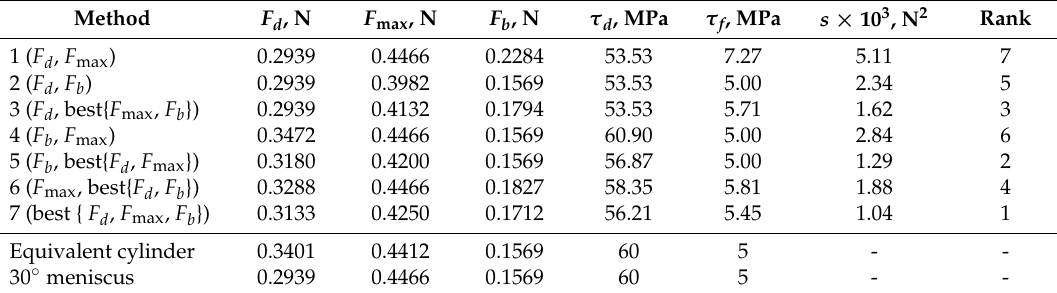
Table 2. Interfacial strength parameters determined from a theoretical force–displacement curve for E-glass fiber–epoxy matrix pair using different methods.